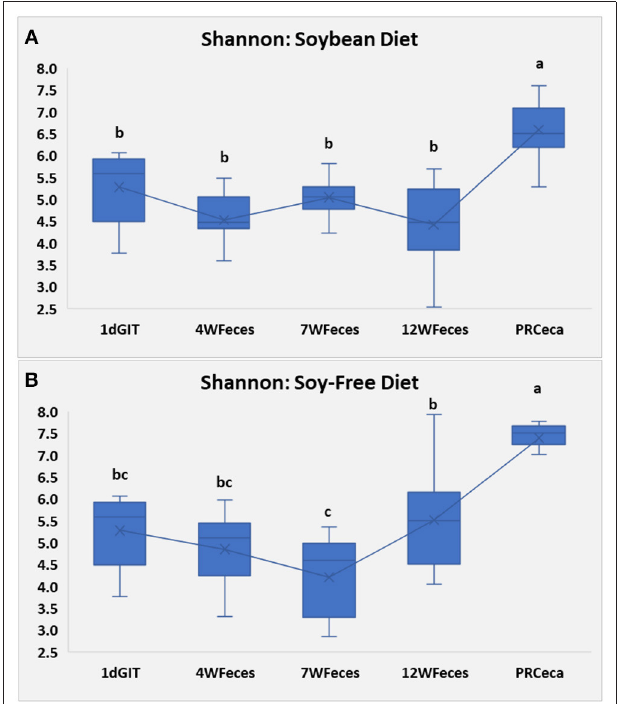
FIGURE 2 | Number of observed OTUs for pasture-raised chicken over different stages of their lives: 1dGIT, Gastrointestinal contents from 1-day-old broilers; 4WFeces, Feces from 4-week-old broilers; 7WFeces, Feces from 7-week-old broilers; 12WFeces, Feces from 12-week-old broilers; PRCeca, Cecal contents collected during slaughter. (A) Broilers fed a soy-containing diet; (B) Broilers fed a soy-free diet. The lack of a common superscript letter (within the same diet) indicates significant differences ( P ≤